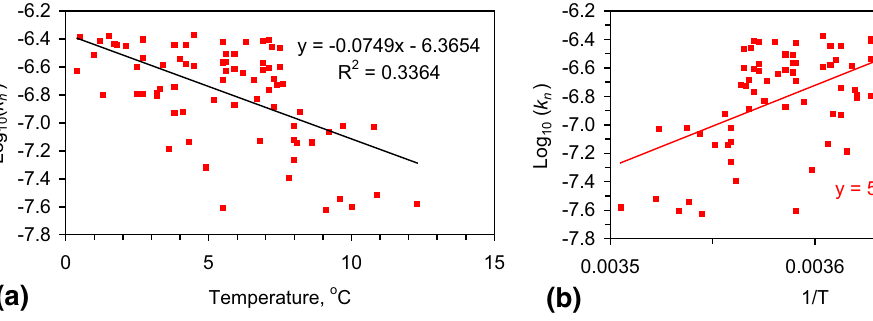
Fig. 4 Catalyst A: activation energy assessment. a Isothermal tem- perature versus k n and b log ( k n ) versus 1/ T . Trial details: reactor size 0.2 L, P w = 18.91 g L −1 , C 0 = 8.2 g L −1 , t = 24 h, number of analyses,